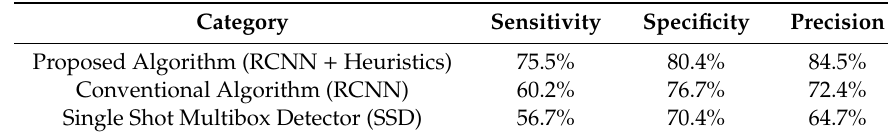
Table 3. Comparison between the proposed algorithm and RCNN.